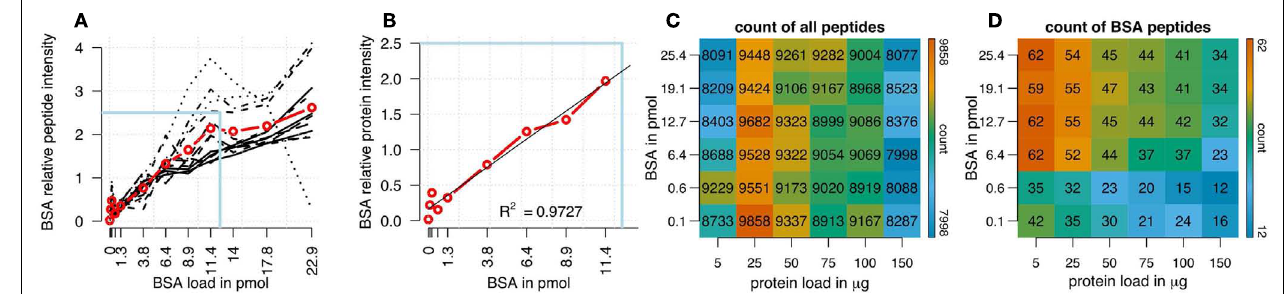
FIGURE 1 | (A) Ion intensities of BSA peptides expressed as fraction of total sample ion intensity. BSA intensities normalized on fraction of total ion intensity sums were proportional to the supplied amounts of BSA. Linearity of averaged intensities (red) was observed for BSA amounts up to 12.8pmol. Variation between relative intensities of different peptides increased for BSA loadings above 5pmol. (B) Enlargement of boxed region in (A) showing linear relationship between the averaged relative ion intensities of BSA peptides and BSA concentrations ( R 2 = 0.97). Count of all identified plant and BSA